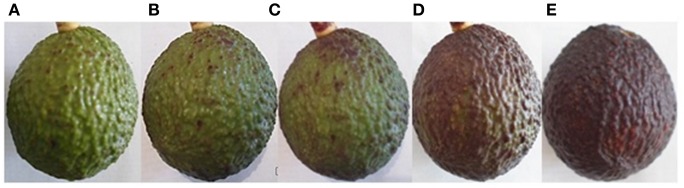
Scale of avocado fruit ripening. (A,B) Post-harvest day, 24% dry Matter, firmness > 120 Newton. (C,D) Intermediate maturity (between day 5 and 8 post-harvest, 25°C), firmness 60–80 Newton. (E) Consumption maturity after 10 days post-harvest, 25°C, firmness < 20 Newton.